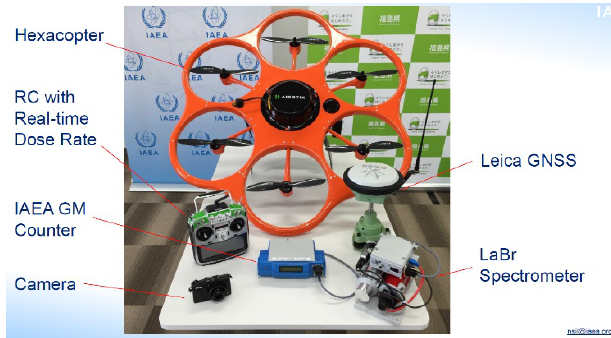
Fig. 2. Set of equipment provided to Japan, it includes two types of detection systems, based on GM and LaBr+PMT detectors. The RC of the UAV exhibits a real time dose rate